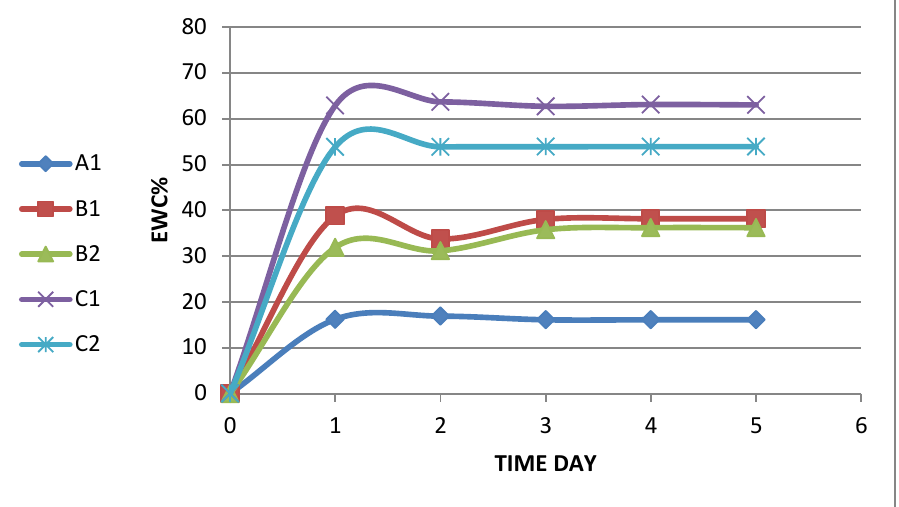
Fig. 11. EWC% for different ratio of